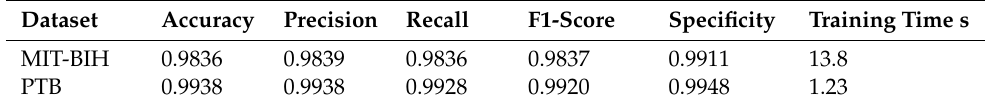
Table 4. Overall performance measurements of ConvXGB.